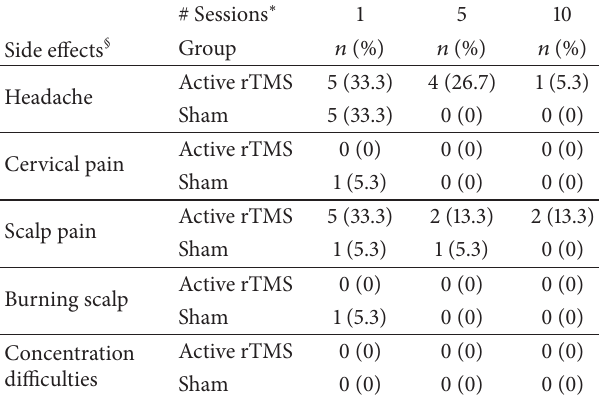
Table 6: Side effects after rTMS sessions.